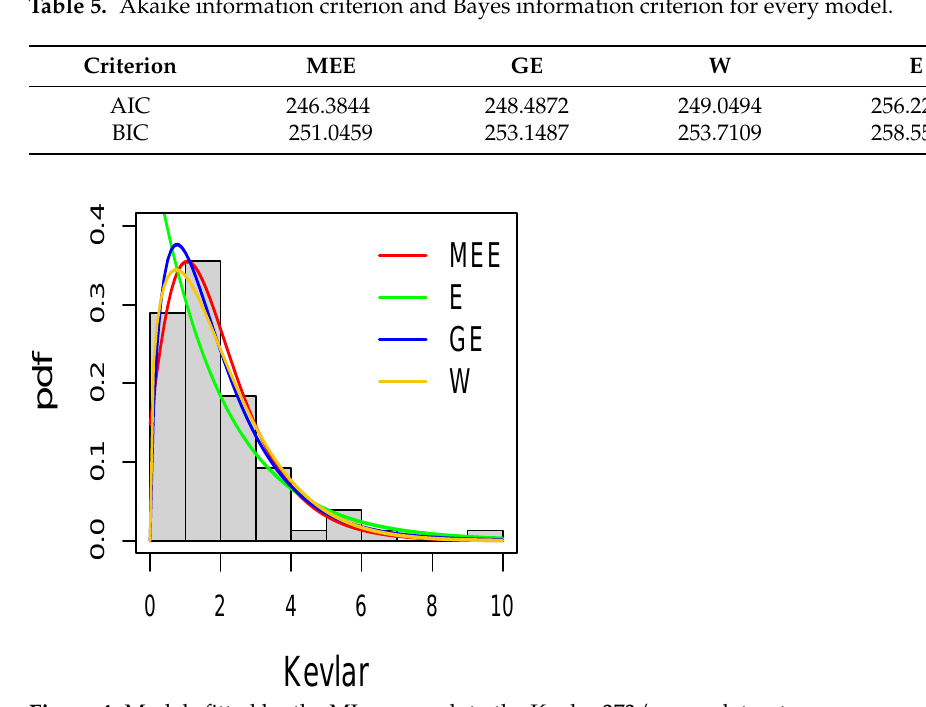
Figure 4. Models fitted by the ML approach to the Kevlar 373/epoxy